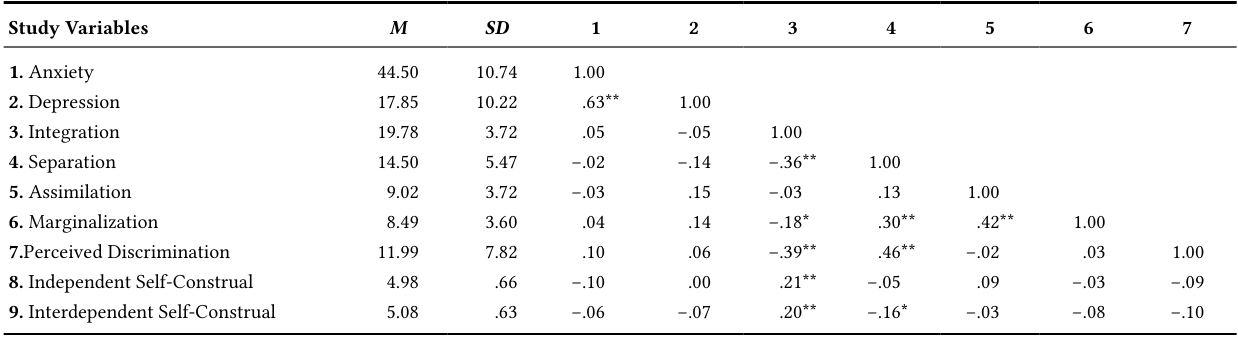
Means, Standard Deviations (SD) and Bivariate Correlations Among Psychological Well-Being, Acculturation Attitudes, Perceived Discrimination, Independent and Interdependent Self-Construal Study Variables